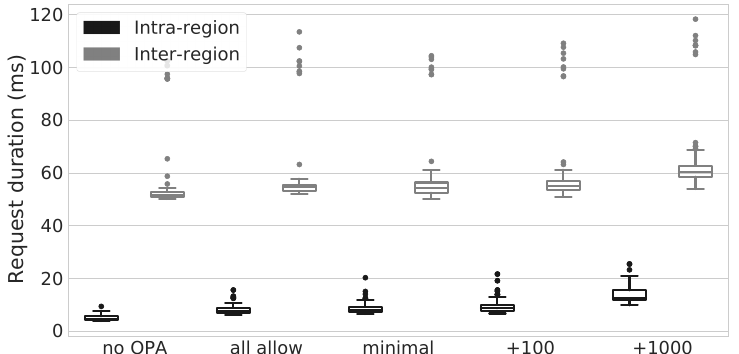
Figure 6. Spread of request duration in intra and inter-region communications by policy